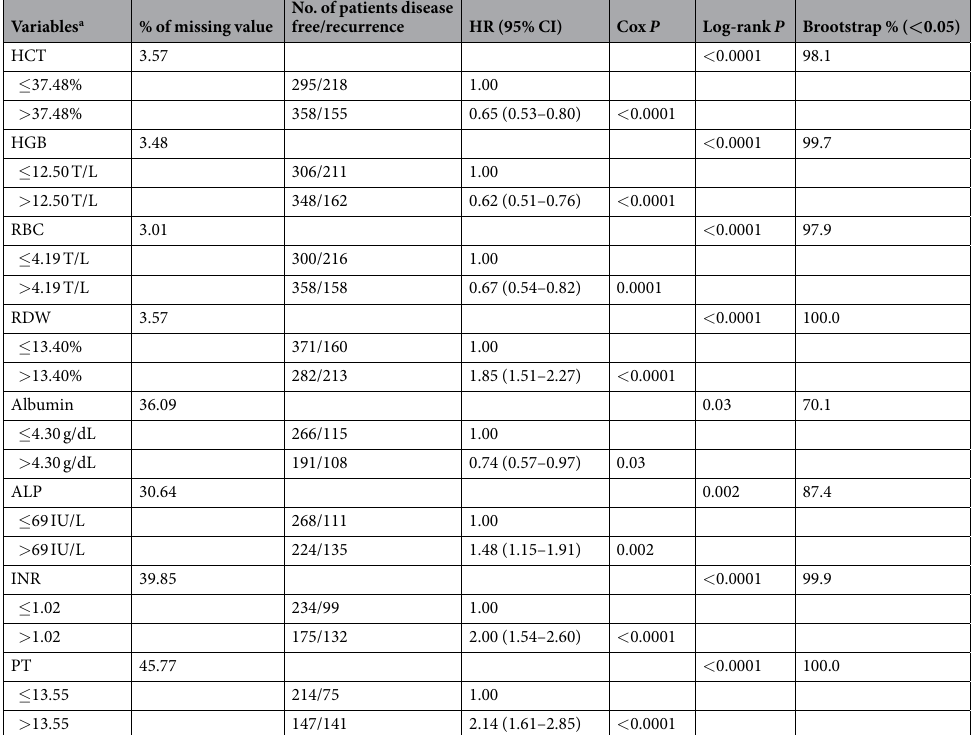
Table 2. Candidate laboratory variables selected by univariate analysis in the training set. Abbreviations: RBC, red blood cell; HGB, hemoglobin; HCT, hematocrit; RDW, red cell distribution width; INR, international normalized ratio; ALP, alkaline phosphatase; HR, hazard ratio; CI, confidence interval. a Variables were categorized by the median value in the study